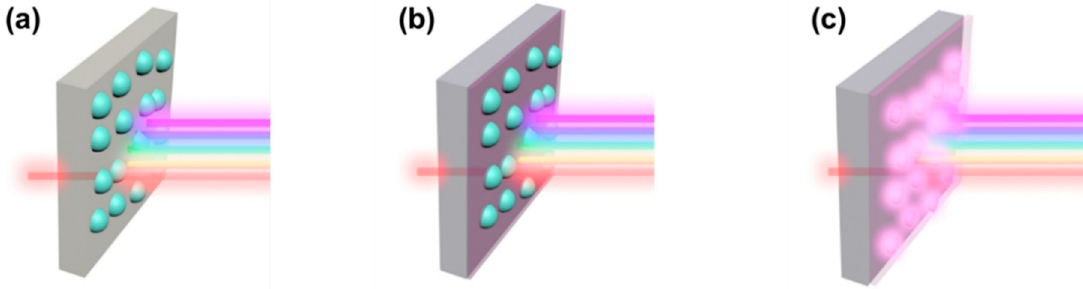
Figure 14. Developments of silicon photocathode with ( a ) co-catalysts, ( b ) adhesive junctions/co-catalysts, and ( c ) overlayers of multi-/mixed-phase chalcogenides.